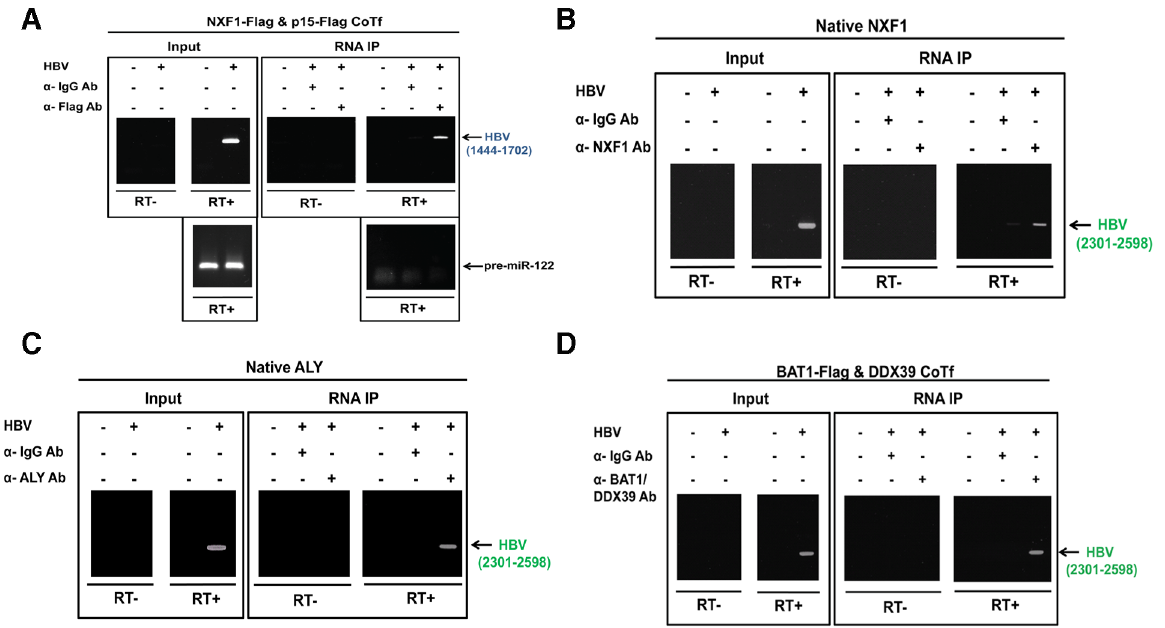
Figure 5. Physical association between HBV pgRNA, TREX and NXF1-p15 complex was revealed by the RNA-immunoprecipitation assay (RNA-IP). A) The NXF1-p15 complex can associate with HBV specific RNAs by the RNA-IP assay. HuH-7 cells were co-transfected with plasmid DNAs of an HBV genome, NXF1-Flag, and p15-Flag. HBV RNAs were extracted from immunoprecipitates using anti-Flag antibody, followed by RT-PCR analysis. PCR primers 1444 and 1702 can detect all species of HBV RNAs (Fig. 1). The most abundant pre-miR-122 in HuH-7 cells was used as a negative control RNA for its lack of physical association with NXF1-p15 complex. Anti-IgG antibody ( a -IgG Ab) was included as a control for the specificity of immunoprecipitation. RT: reverse transcriptase. B–D) By the RNA-IP assay, HBV 3.5 kb non-spliced pgRNA was shown to be associated with several known protein components of the NXF1-p15 mediated RNA export machinery: B) NXF1, C) ALY, and D) BAT1/DDX39. PCR primers 2301 and 2598 can detect only the 3.5 kb non-spliced pgRNA (Fig. 1).